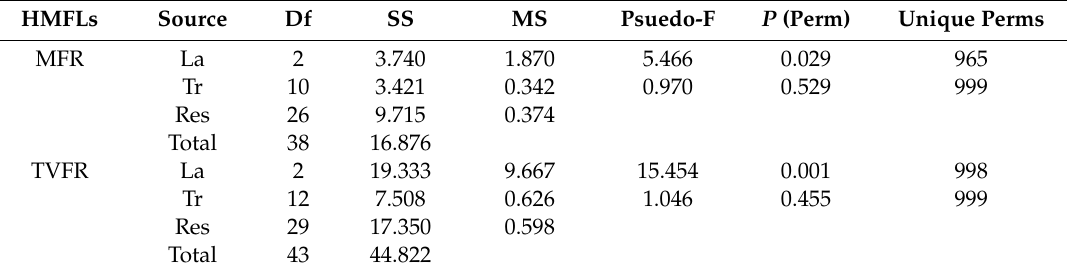
Table 5. PERMANOVA results for richness di ff erence between land use intensity in human modified forest landscape (HMFL) at Mafhela (MFR) and Thathe Vondo Forest Reserve (TVFR). HMFLs Source Df SS MS Psuedo-F P